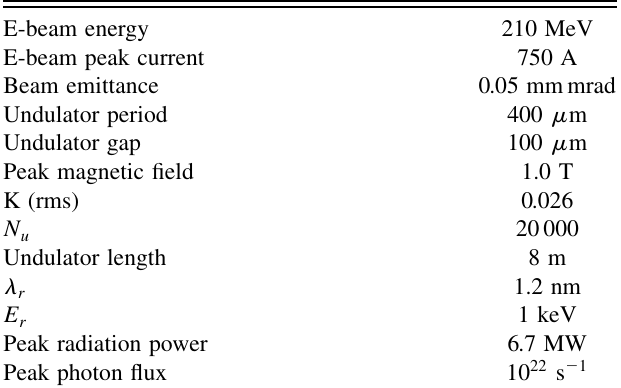
SURFACE-MICROMACHINED MAGNETIC UNDULATOR WITH . . . Phys. Rev. STAccel. Beams 15, 070703 TABLE II. Parameters of a high-average-power soft x-ray TABLE III. Parameters of a high-gain soft x-ray FEL amplifier ¼ 400 (cid:1) m MEMS undulator. source based on a (cid:2) based on a 400 (cid:1) m MEMS undulator. u